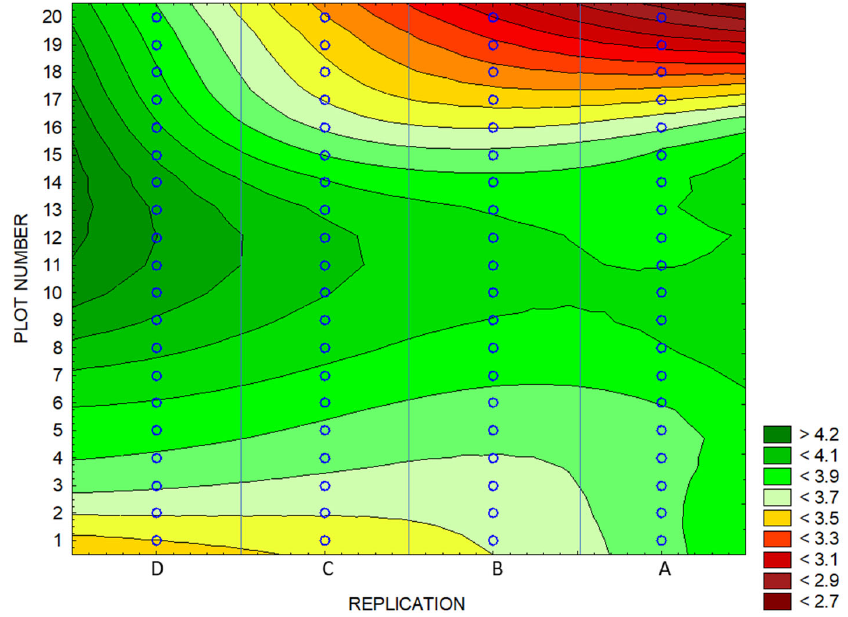
Figure 16. Contour map of NDYI. Blue circles illustrate plot centers.